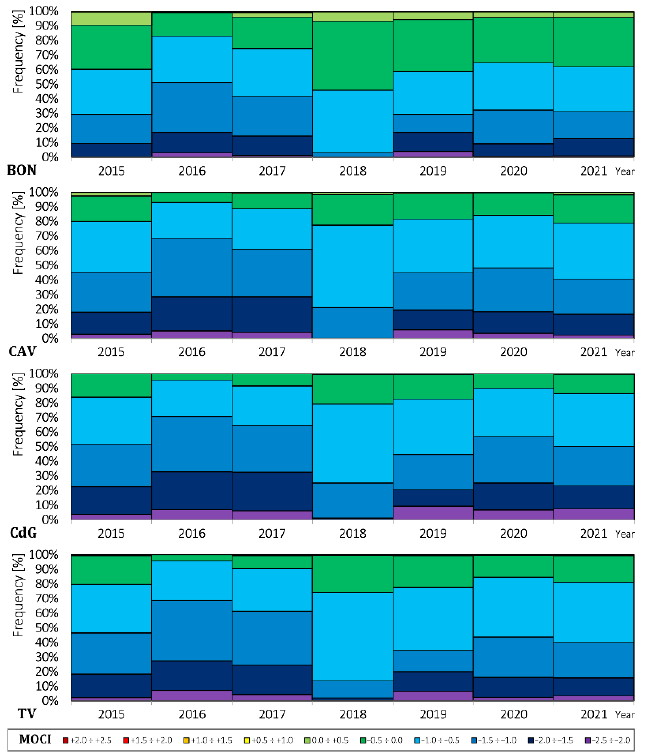
Figure 5. MOCI frequencies for the four ARPA stations. The frequencies are calculated using nocturnal (from 20:00 to 05:00 LT) hourly data and are presented in yearly units.